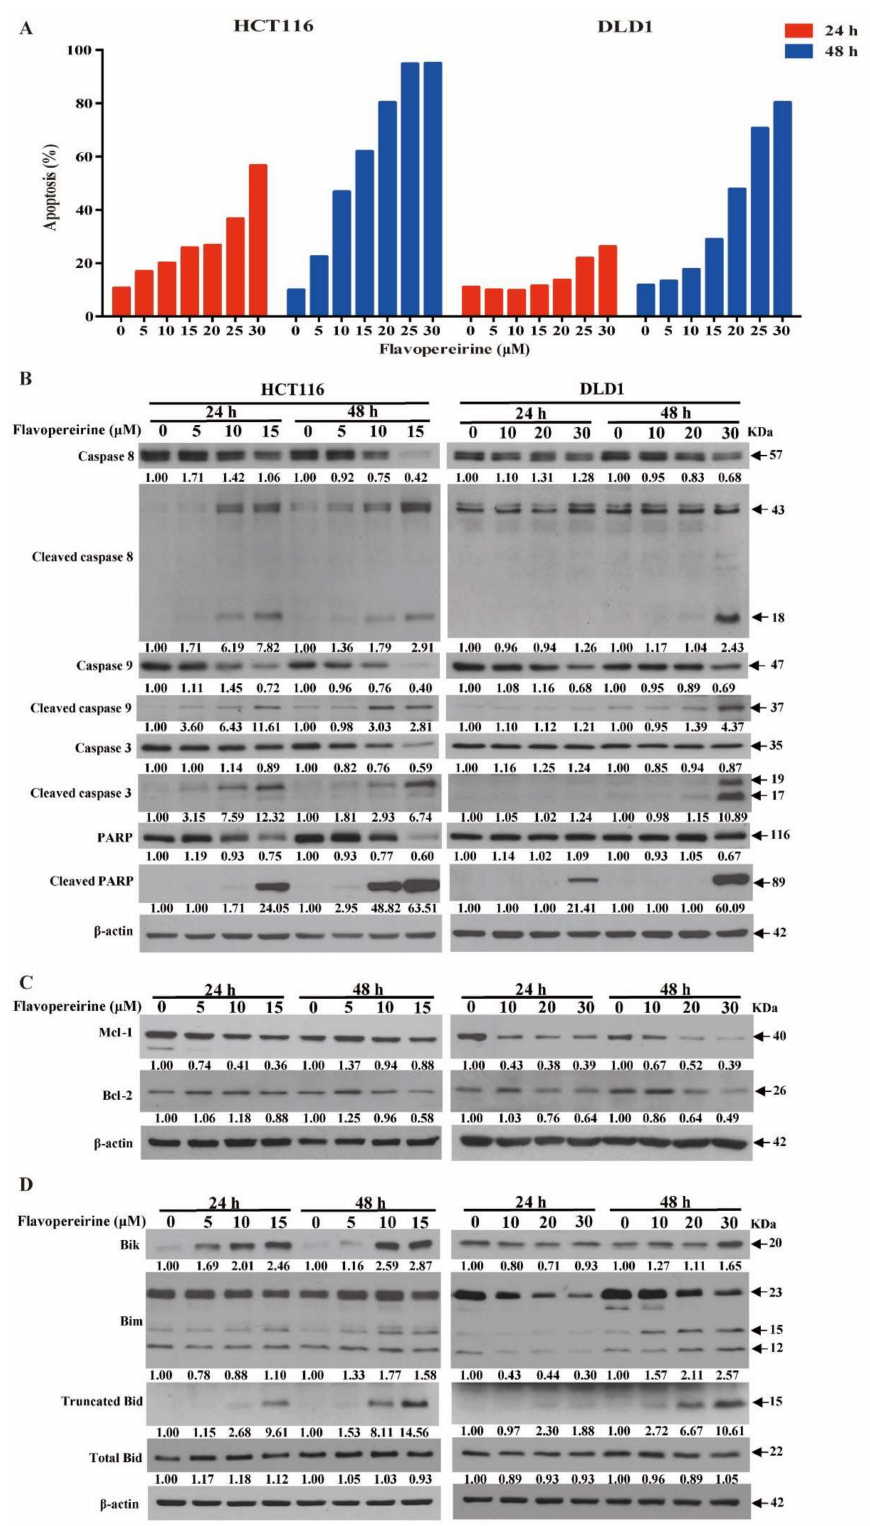
Figure 2. Flavopereirine induced both extrinsic and intrinsic apoptosis in CRC cells. ( A ) Flavopereirine-induced apoptosis in HCT116 and DLD1 cells was assayed and quantified after 24 h and 48 h treatment. ( B ) Flavopereirine promoted the cleavage of caspase-8, -9, and -3 and PARP. ( C , D ) Flavopereirine downregulated the pro-survival Bcl-2 family proteins and upregulated the pro-apoptotic proteins Mcl-1, Bcl-2, Bik, Bim, and Truncated Bid. Numbers under the plots indicate the fold change of protein level relative to their untreated control. Similar results were obtained in at least three independent